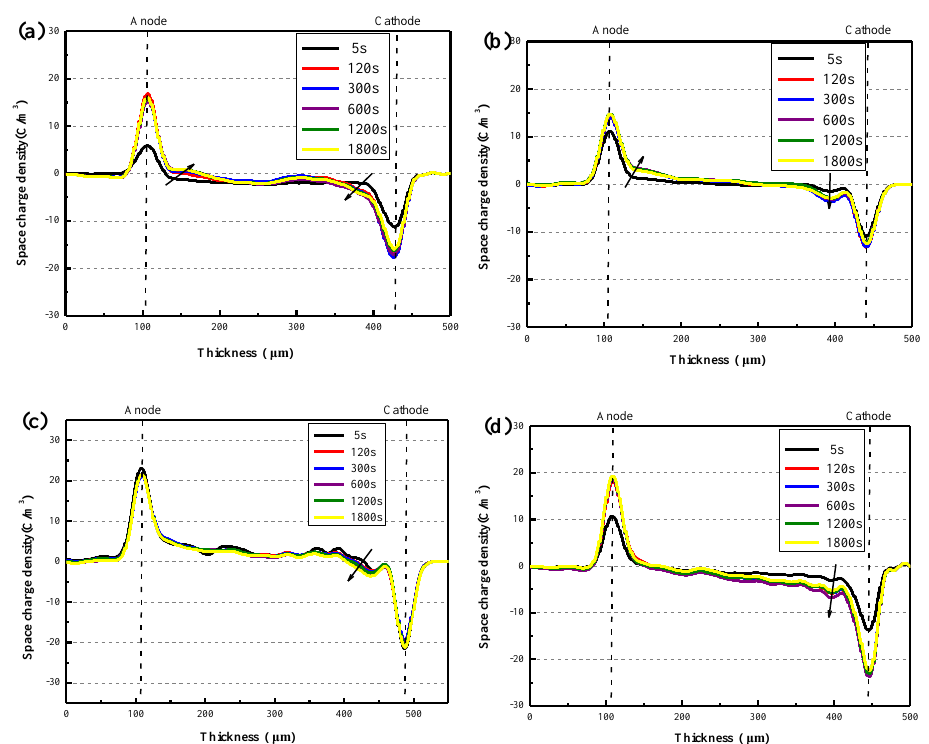
Figure 11. ( a ) The space charge density of pure XLPE varies with the application time of DC voltage (20 kV / mm), ( b – d ) The space charge density of the XLPE / α -Al 2 O 3 nanocomposites containing 0.2 wt %, 0.5 wt %, and 1.0 wt % α -Al 2 O 3 varies with the application time of DC voltage (25 kV / mm).